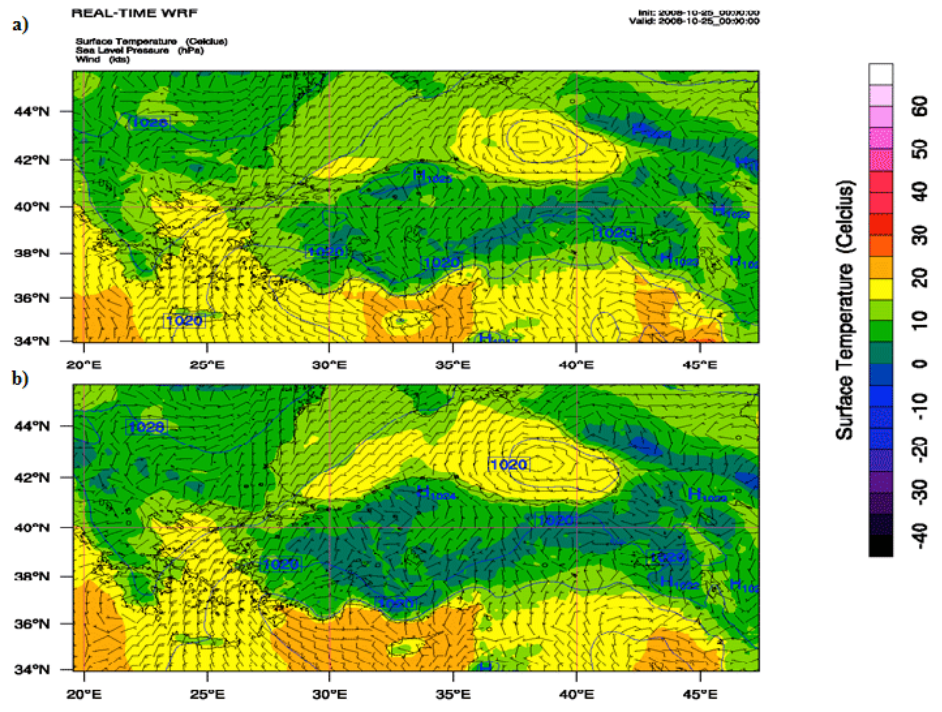
Fig. 2. The distribution of initial surface temperature, contours of sea level pressure and wind vectors for coarse domain on 25 October 2008 at 00:00UTC (a) for WRF without assimilation (control) and (b) for WRF with